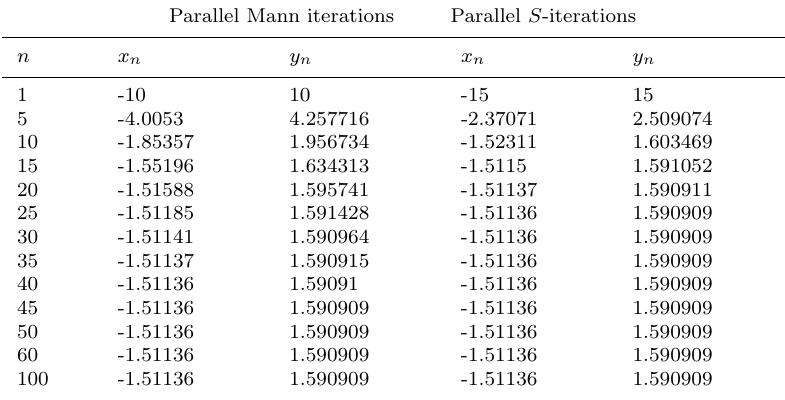
Convergence of parallel Mann iterative method (3.13) and parallel S -iterative method (3.14).